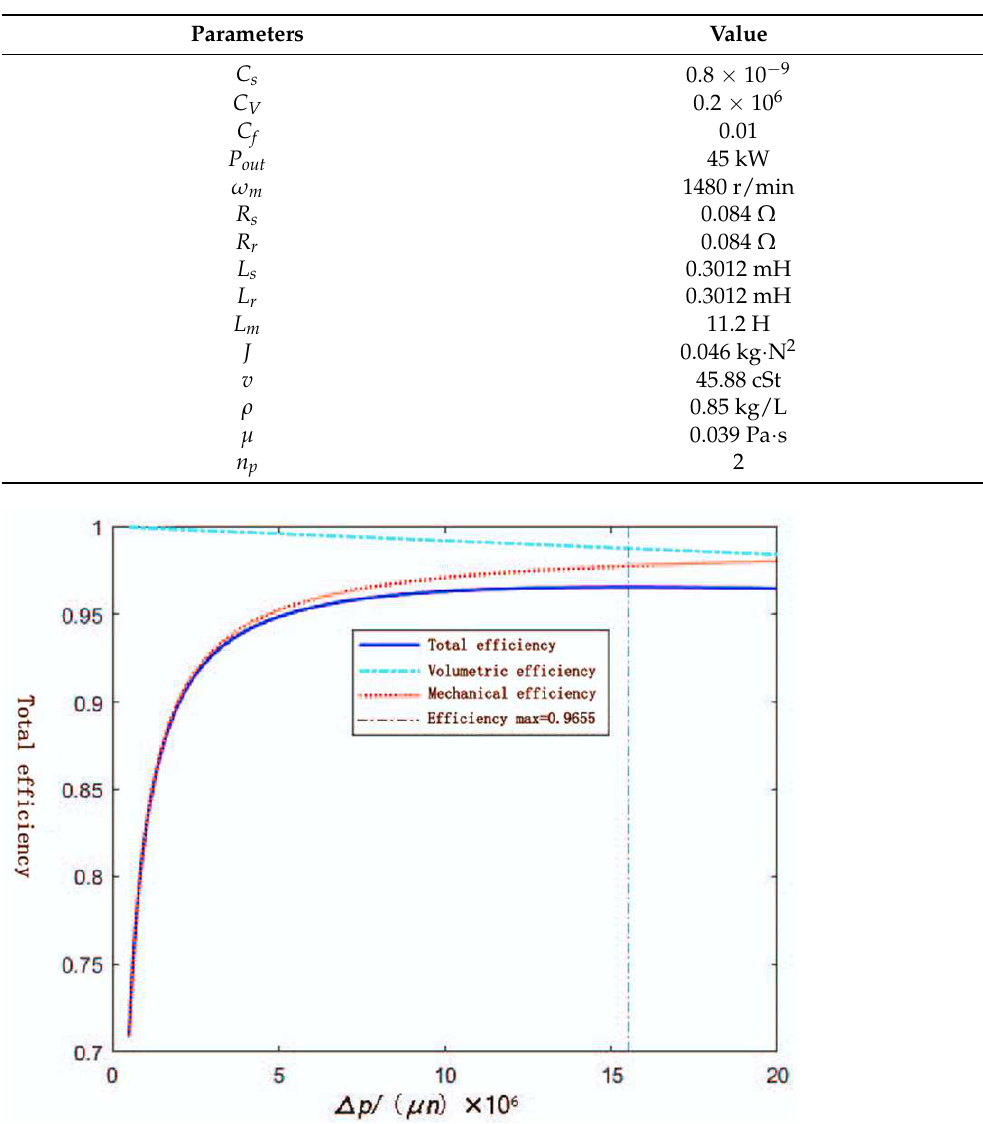
Table 1. The parameters of the values.